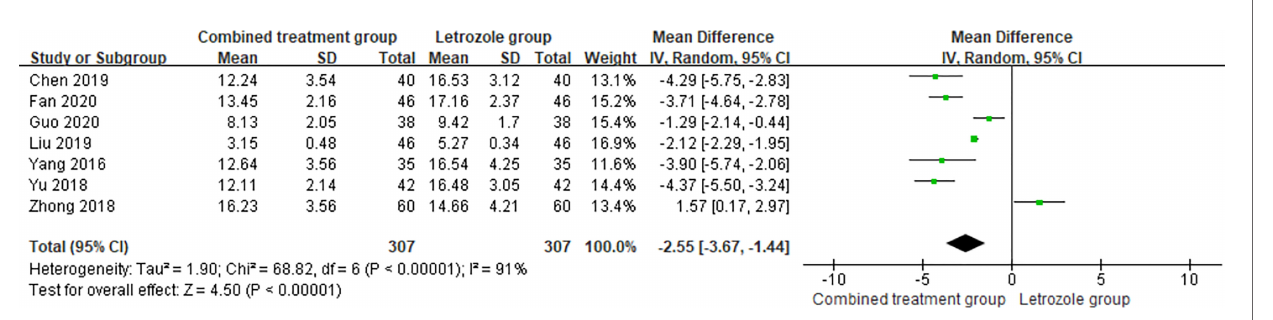
FIGURE 5 | Meta-analysis of the effect of Kuntai capsule combined with letrozole on serum follicle stimulating hormone (FSH) in polycystic ovary syndrome (PCOS) treatment.